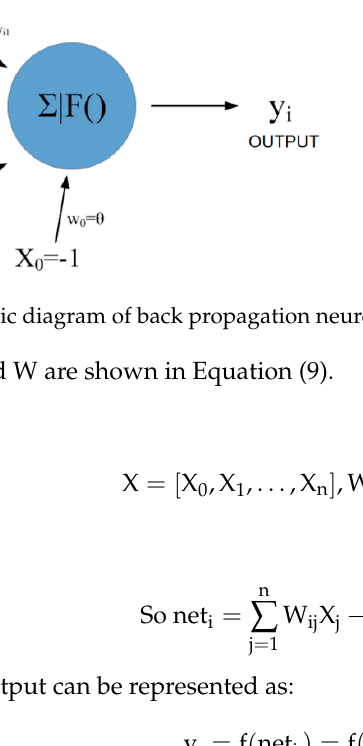
Figure 9. Schematic diagram of b ack p ropagation neural network. Each hidden layer contains multiple neurons. The neuron format is shown in Figure 10. The number of input X and output Y is set as required, but X 0 is the specified value − 1. Each input corresponds to a weight win, and X 0 corresponds to w 0 θ . In the calculation process, the sum is first and then the mapping is performed.